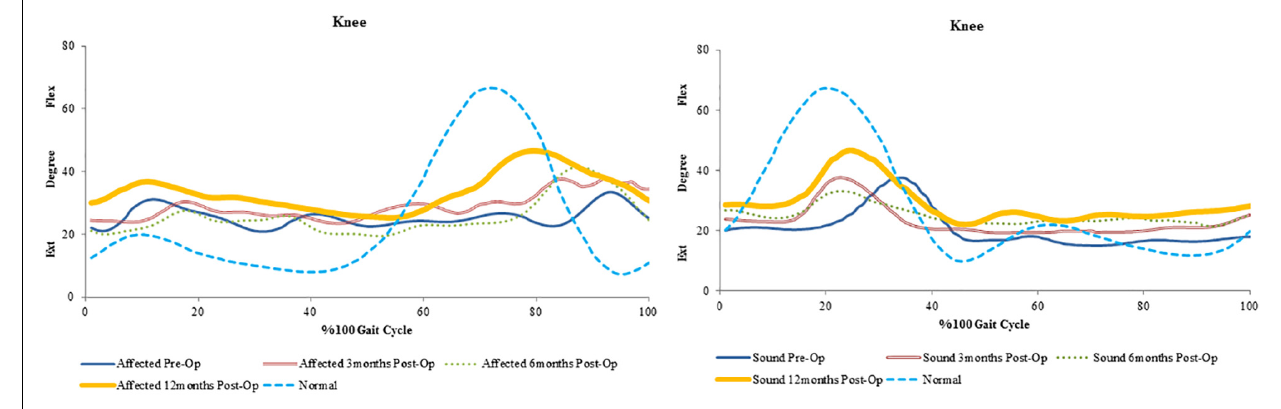
FIGURE 4 | Mean trends of hip, knee and ankle flexion-extension in the affected and sound side during gait cycle in spastic patient